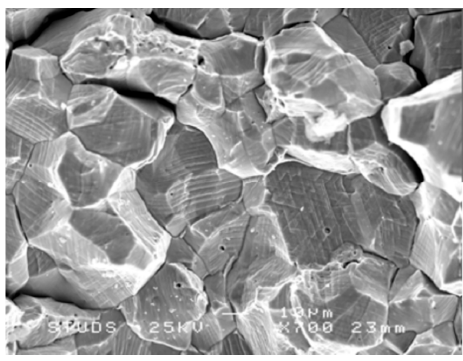
Figure 5. IG fracture of thin tensile specimens from the wide range neutron monitor guide tube of A304 steel irradiated in BWR to ~80 dpa and tensile tested at room temperature [19]. Reproduced with